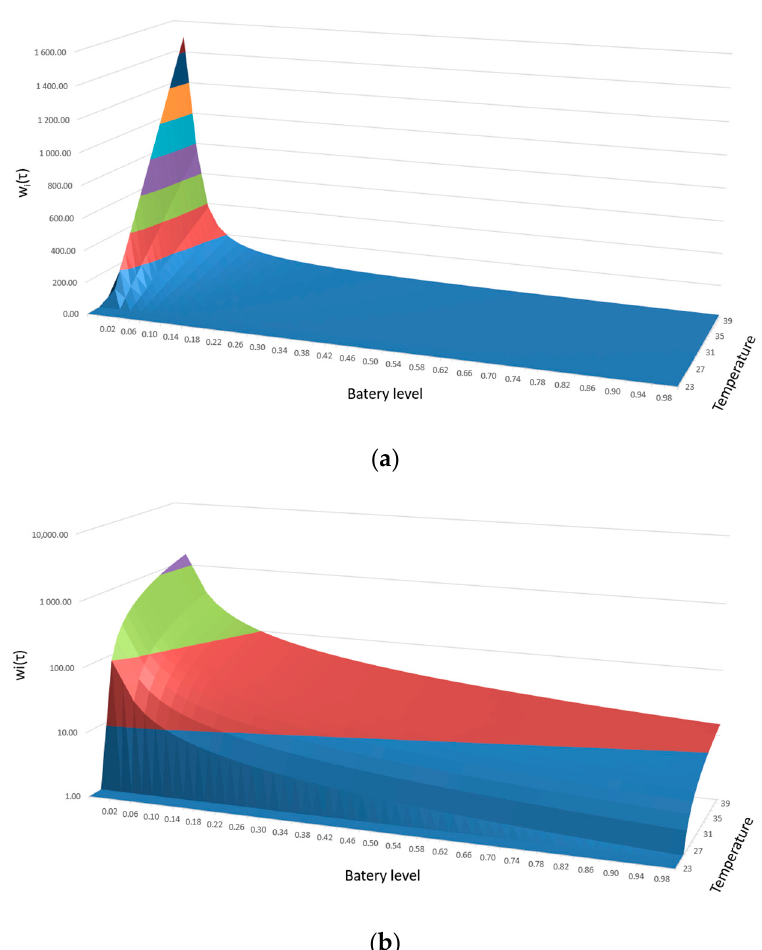
Figure 1. The dependence of the impact of w i ( τ ) of a given node on the temperature increase and battery level; ( a ) standard chart; ( b ) logarithmic chart.